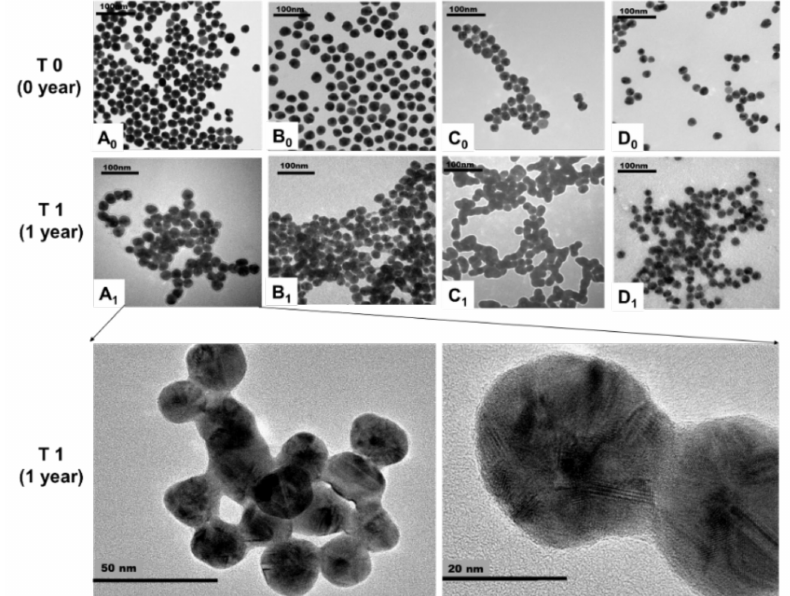
Figure 3. TEM images of surface-modified AgNPs. A 0 – D 0 : The initial images of Citrate AgNPs, PEG AgNPs, PVP AgNPs, and BPEI AgNPs. A 1 – D 1 : The one-year TEM images of Citrate AgNPs, PEG AgNPs, PVP AgNPs, and BPEI AgNPs in storage medium.